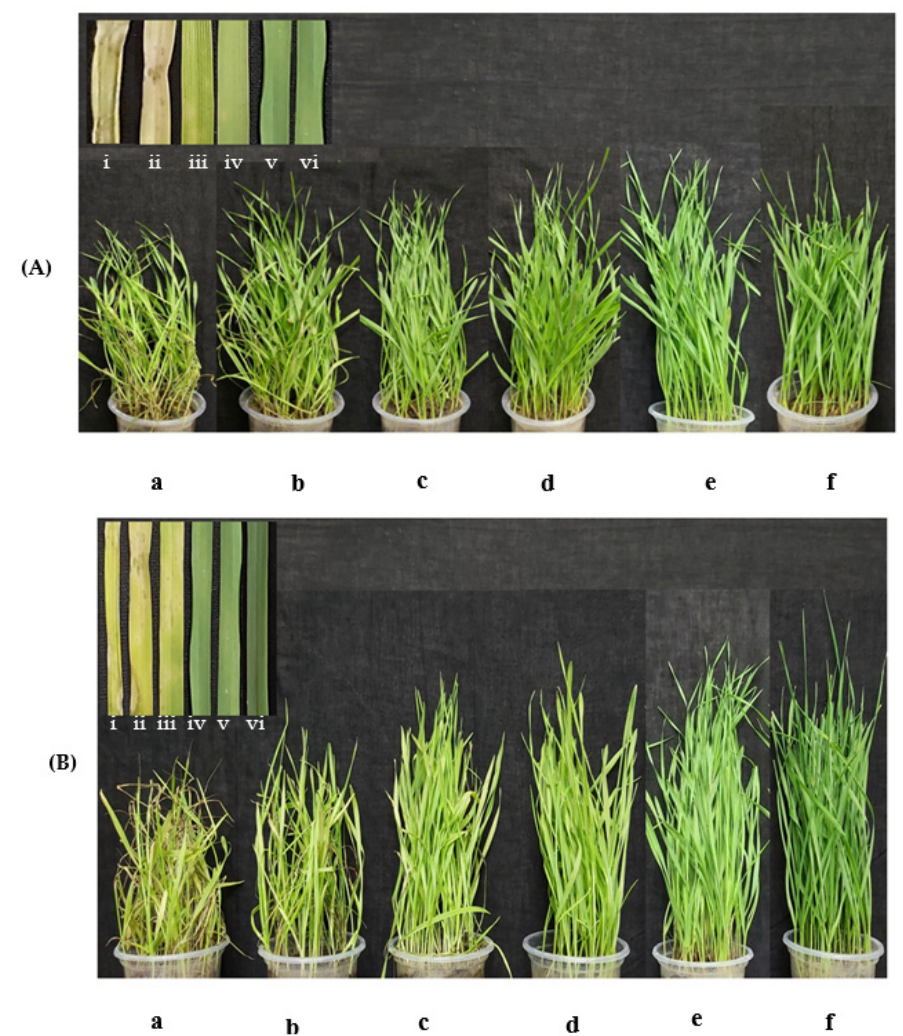
Figure 6. Suppression of wheat blast disease by antimycin A and Nativo ® 75 WG. Herein, blast lesions suppressed by different doses of antimycin A, a commercial dose of Nativo ® 75 WG, as well as untreated and healthy control wheat seedlings were presented as ( A ) preventive, and ( B ) curative. Both preventive and curative assays included (a) water control + MoT, (b–d) antimycin A + MoT inoculation, (e) commercial dose of Nativo ® 75 WG + MoT inoculation, and (f) non-inoculated, non-treated seedlings. The 1 µg/mL, 5 µg/mL, and 10 µg/mL dose of antimycin A are represented as (b), (c), and (d), respectively. In inset, the representative leaf sample is presented as (i) water control + MoT, (ii–iv) antimycin A at 1 µg/mL, 5 µg/mL, and 10 µg/mL, respectively + MoT inoculation, (v) commercial dose of Nativo ® 75 WG + MoT inoculation, and (vi) non-inoculated, non-treated seedlings as a healthy control. Photos were taken 21 days after inoculation.